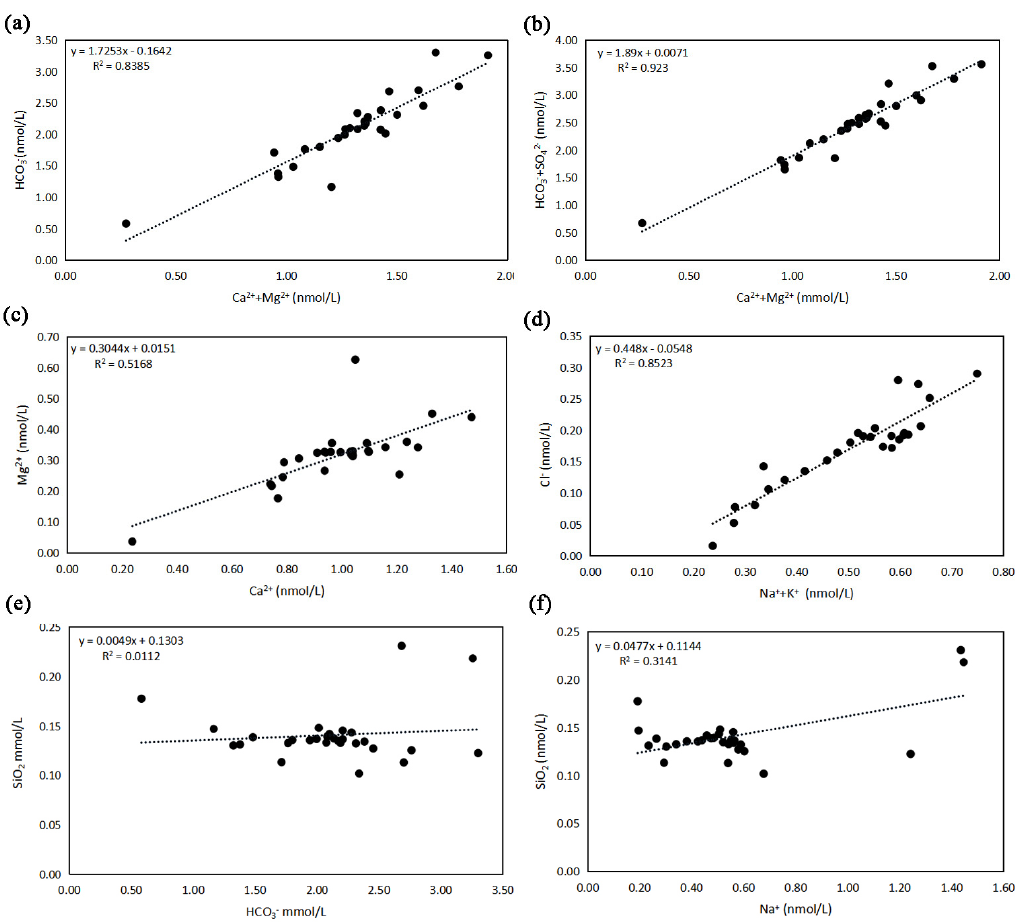
Figure 7. Proportion of major ions in Yarlung Tsangpo River water. The dotted line represents the fitting line. The black dots represent the sampling points.